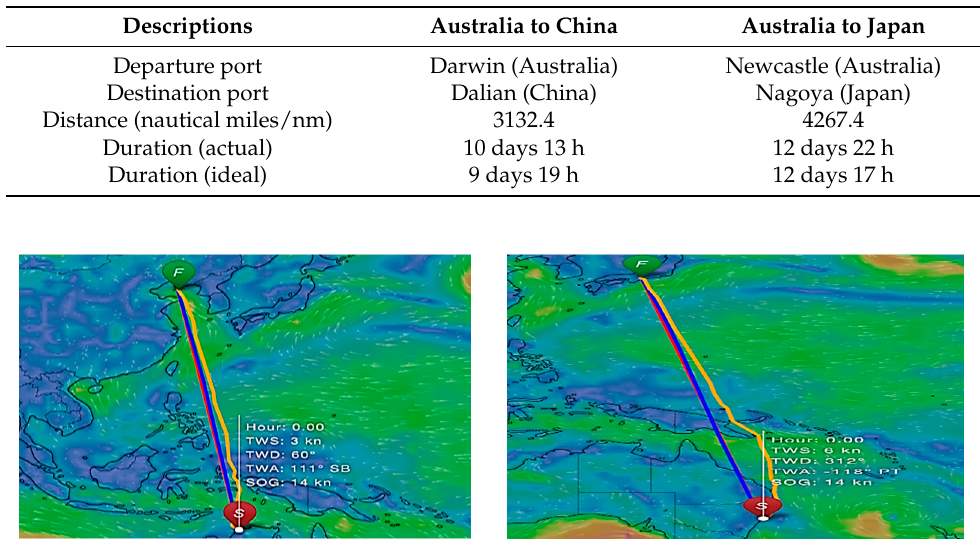
Figure 2. Route from Australia to China ( left ) and Japan ( right ) using FastSeas.